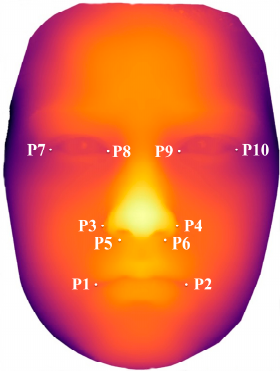
Figure 1. A 3D facial scan (shown in false color for anonymization) showing the landmarks for distance measurements P1–P2: right and left angulus oris (mouth breadth); P3–P4: distance between right and left alar nasi; P5–P6: distance between right and left sulcus alaris; P8–P9: inner canthal distance; P7–P8: right palpebral fissure length; P9–P10: left palpebral fissure length.